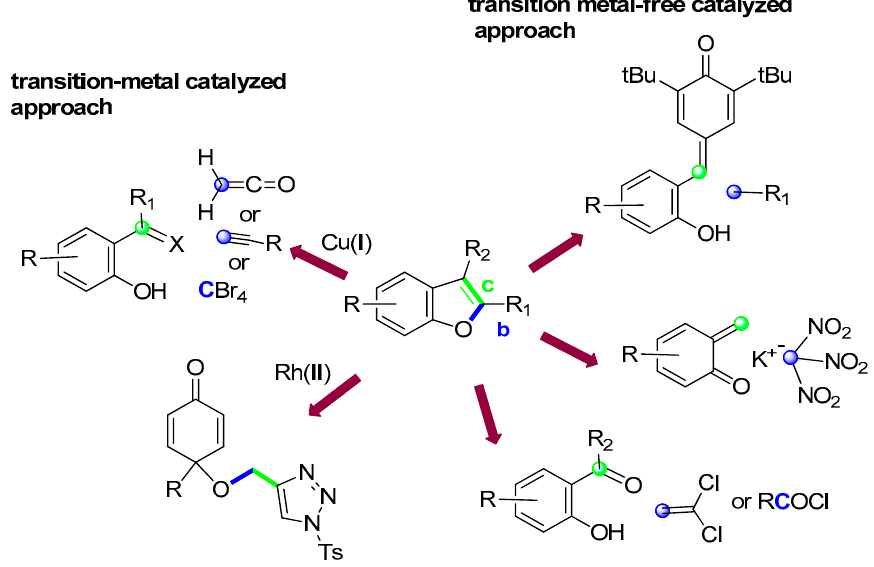
Scheme 33. Approaches for the O–C2 and C2–C3 bond formation.